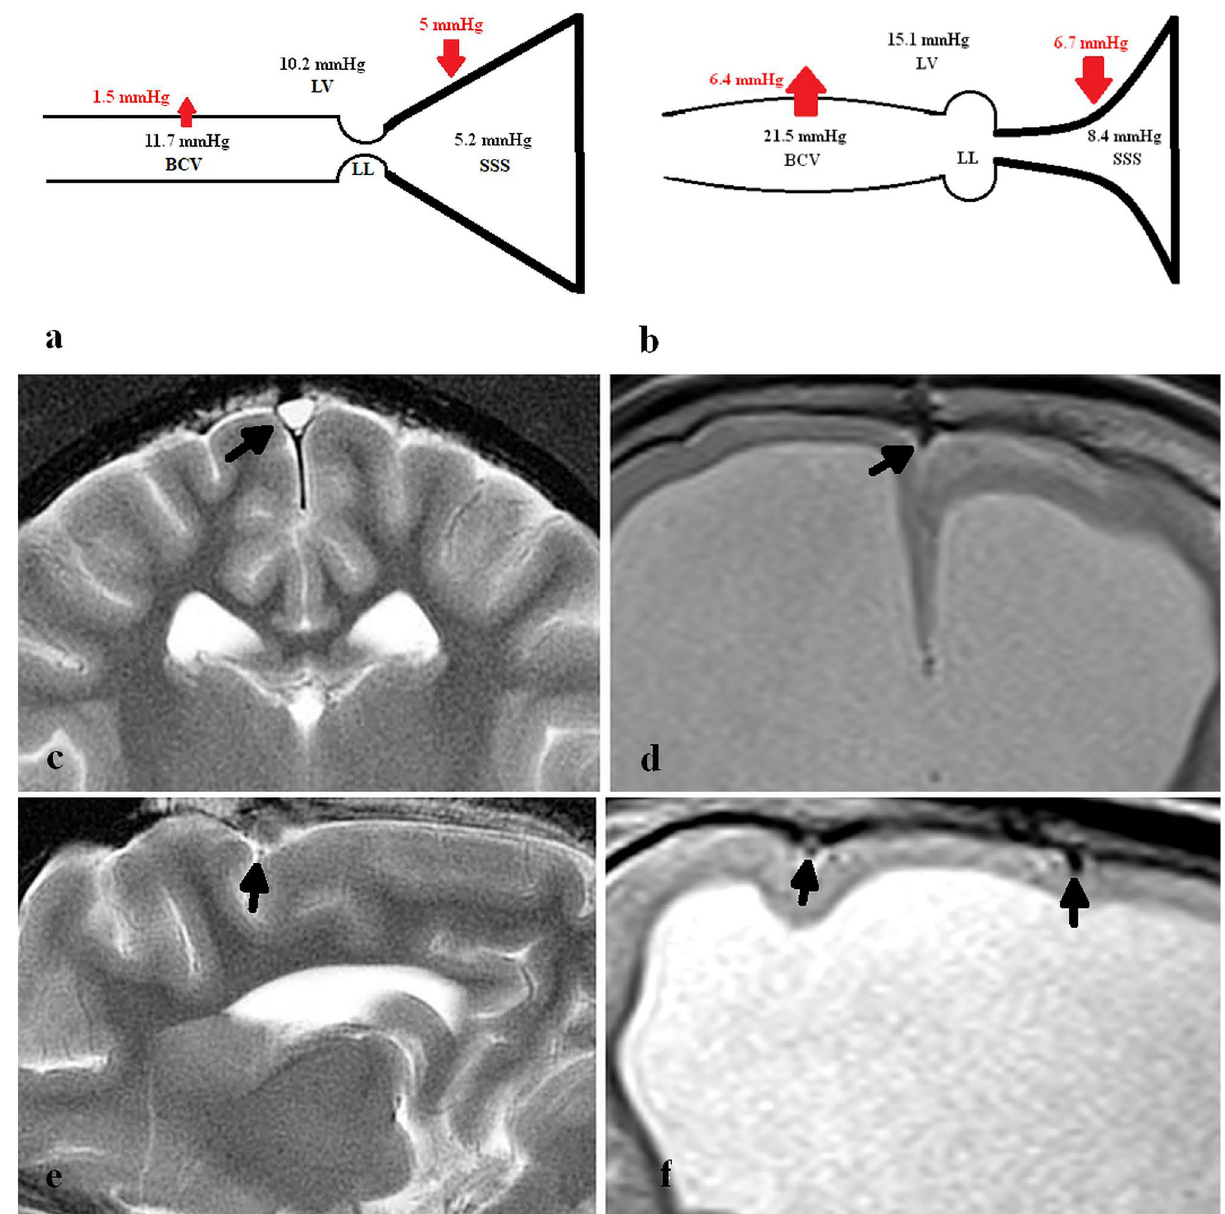
Figure 1. Pressure changes in the naturally occurring hydrocephalus in dogs. ( a ) A diagram of the bridging cortical vein (BCV), lateral lacunae (LL), superior sagittal sinus (SSS) and lateral ventricle (LV) with pressures in normal dogs appended from Portnoy et al. 5 . The pressure differences across vein walls are shown in red with arrows. ( b ) A diagram of the pressures found in dogs with a naturally occurring form of hydrocephalus from Portnoy et al. 5 . Note the pressure across the sagittal sinus wall is increased by 1.7 mmHg and the vein is compressed. The pressure across the BCV is increased by 327% and the vein is depicted as dilated. ( c ) A coronal T2 image of a normal dog with the arrow indicating the superior sagittal sinus. ( d ) A coronal T2 image of a naturally hydrocephalic dog showing the sagittal sinus to be much smaller than in 1c. ( e ) A sagittal T2 slice, just off centre, in a normal dog showing a BCV as a black dot at the arrow head. ( f ) A sagittal slice from the hydrocephalic dog showing significantly dilated BCVs sinus pressures in the controls were 10.2, 11.7 and 5.2 mmHg respectively, with hydrocephalic dogs being 15.1, 21.5 and 8.4 mmHg respectively 5 (see Fig. 1a,b). Note the sagittal sinus pressure is mildly increased by 3.2 mmHg but the BCV pressure is increased by 9.8 mmHg in hydrocephalus compared to controls. The increase in sinus pressure in hydrocephalic dogs can be explained by venous collapse. Modelling of hydrocephalus in dogs shows the entire sinus length to be narrowed 6 (see Fig. 1c,d). In dogs, between the cortical veins and the superior sagittal sinus, lie the lateral lacunae, which are small venous lakes between the leaves of dura which are thought to act as Starling resistors 5 . The BCV transmural pressure is increased by 327% in hydrocephalic dogs 5 . The cause of